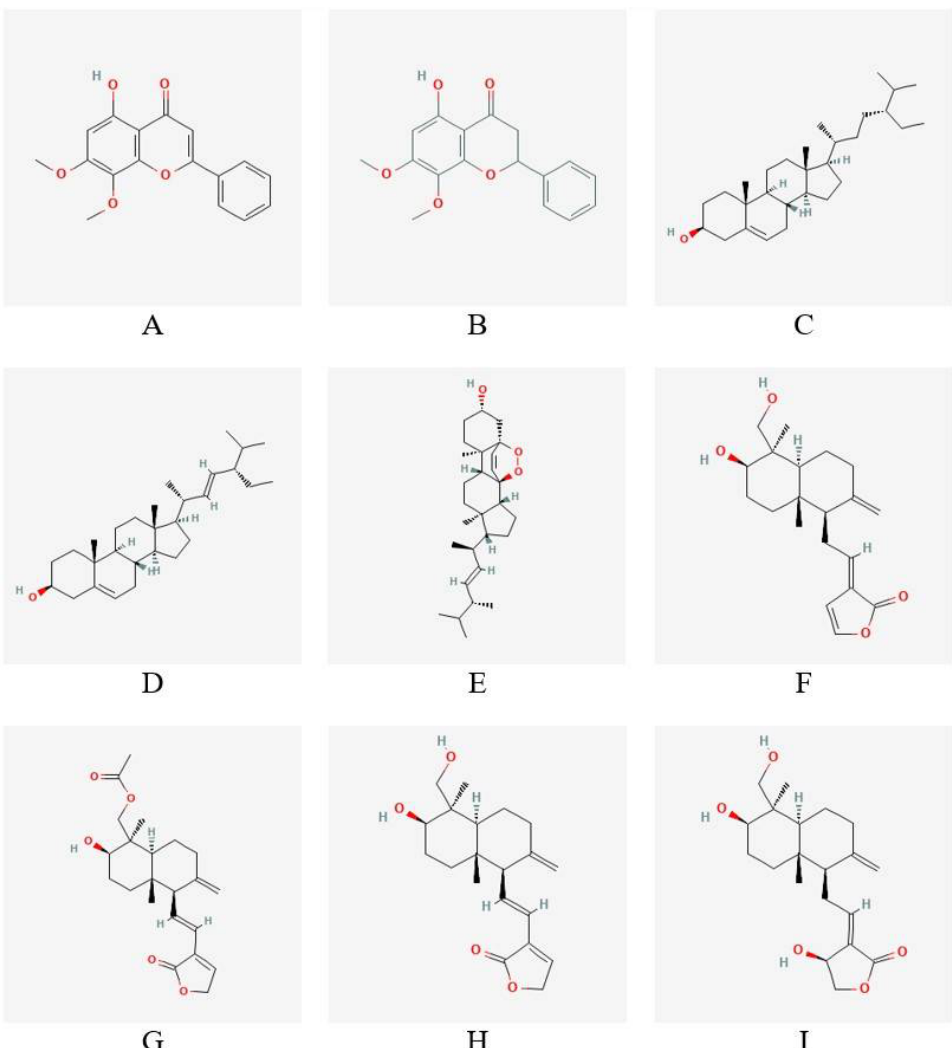
Figure 3. Molecular structures of the compounds from Andrographis paniculata that inhibit NF- κ B transactivation: ( A ) 5-hydroxy-7,8-dimethoxyflavone, ( B ) 5-hydroxy-7,8dimethoxyflavanone, ( C ) β - itosterol, ( D ) stigmasterol, ( E ) ergosterol peroxide, ( F ) 14-deoxy14,15-dehydroandrographolide, ( G ) 19-O-acetyl-14-deoxy-11,12-didehydroandrographolide, ( H ) 14-deoxy-11,12-didehydroandrographolide, and ( I ) andrographolide.